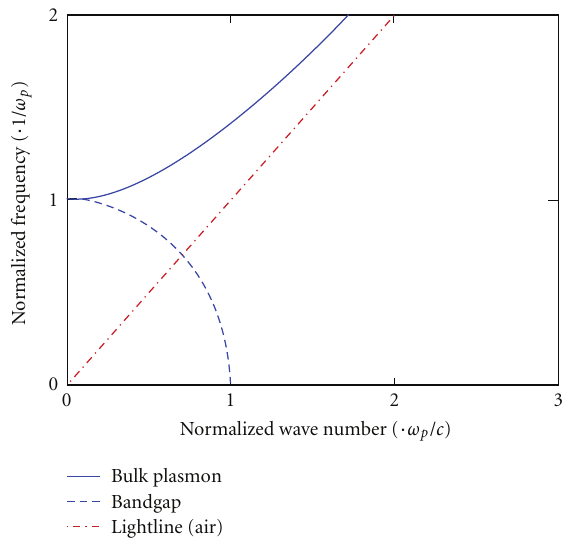
Figure 3: Dispersion relation of free electron gas (solid) compared to that of lightline of dielectric material